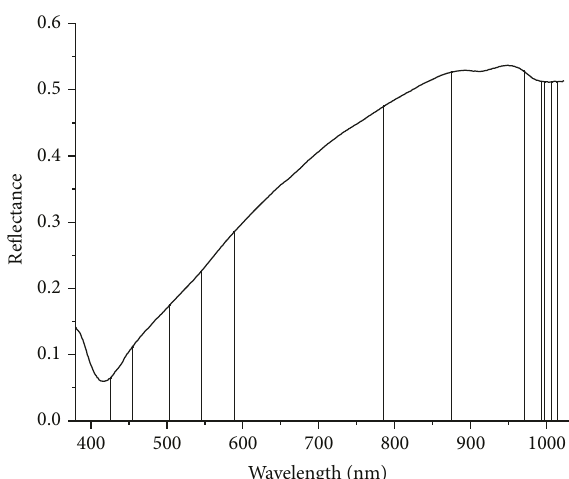
Figure 7: RMSECV of 16 intervals.